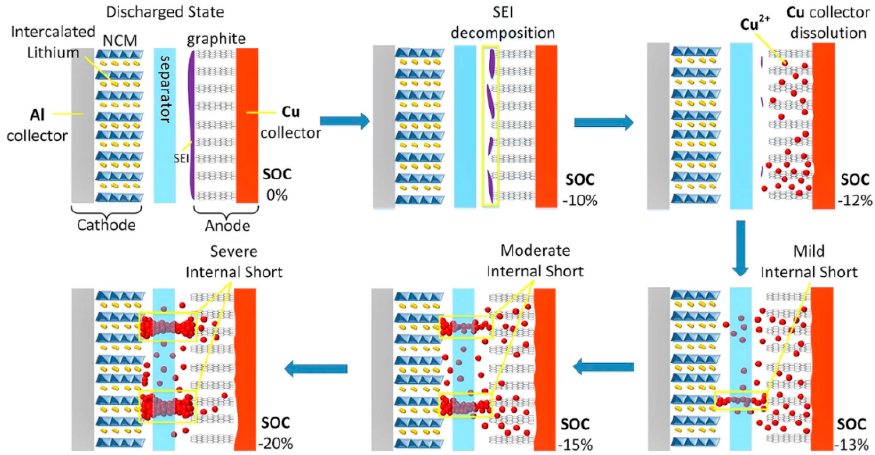
Figure 10. Copper dissolution and deposition during overdischarge and formation of ISC [84].